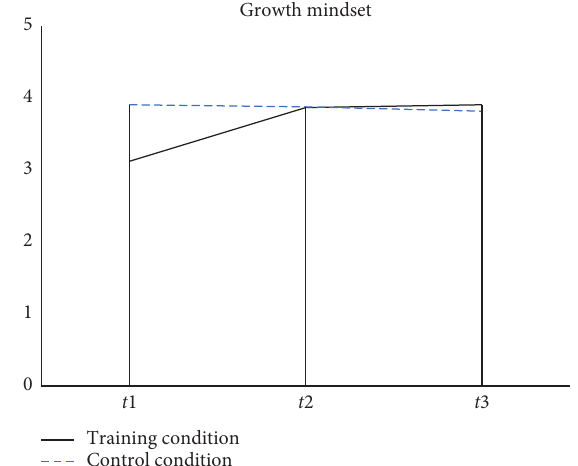
Figure 2: Development of growth mindsets in both